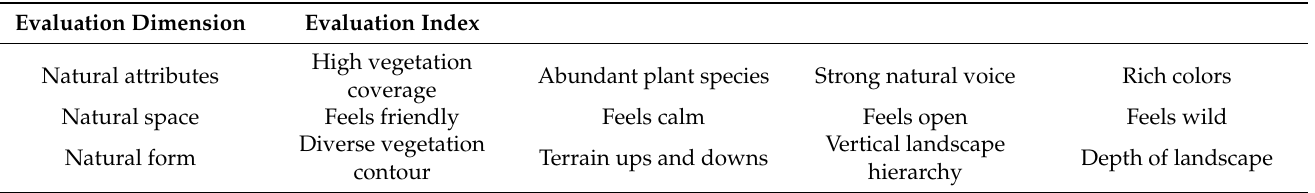
Table 2. Perceived naturalness scale.